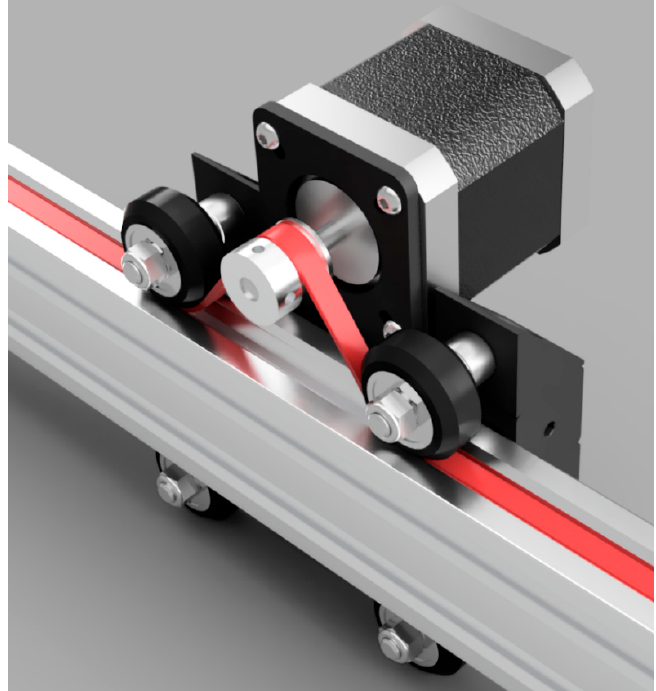
Figure 1. Belt-and-pinion drive system. The timing belt (red) passes under the drive wheels and over the timing pulley to maintain tension in the belt. Drawing files from [10].